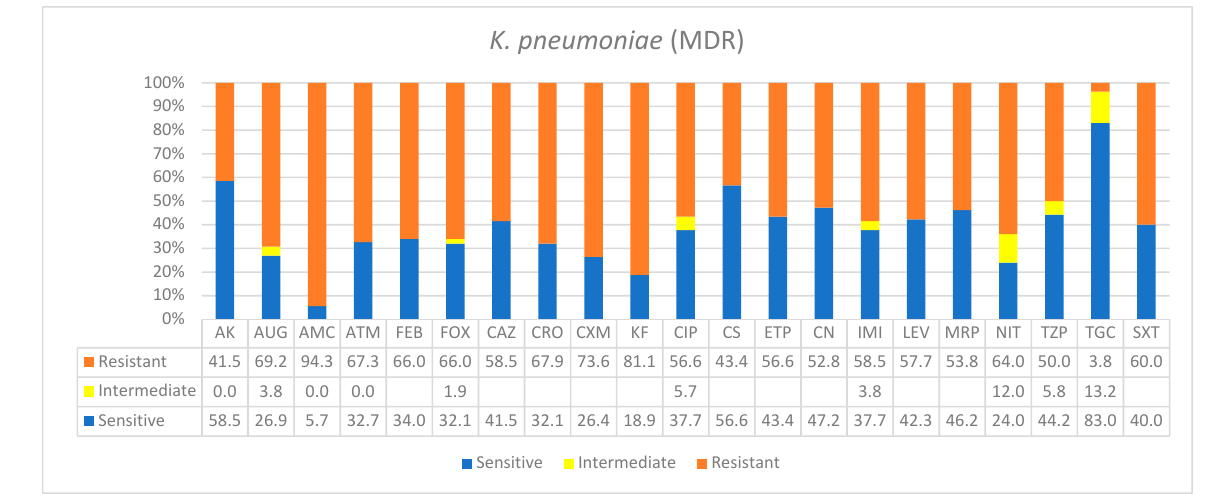
Figure 1. Antimicrobial sensitivity patterns of K. pneumoniae clinical isolates against 21 antibiotics. Abbreviations (in the order in which they appear in the figure): AK, amikacin; AUG, amoxicillin/clavulanic acid (2/1); AMC ampicillin*/sulbactam (2/1); ATM, aztreonam; FEP, cefepime; FOX, cefoxitin; CAZ, ceftazidime; CRO, ceftriaxone; CXM, cefuroxime; KF, cephalothin; CIP, ciprofloxacin; CS, colistin; ETP, ertapenem; CN, gentamicin; IMI, imipenem; LEV, levofloxacin; MRP, meropenem; NIT, nitrofurantoin; TZP, tazobactam; TGC, tigecycline; SXT, trimethoprim/sulfamethoxazole.